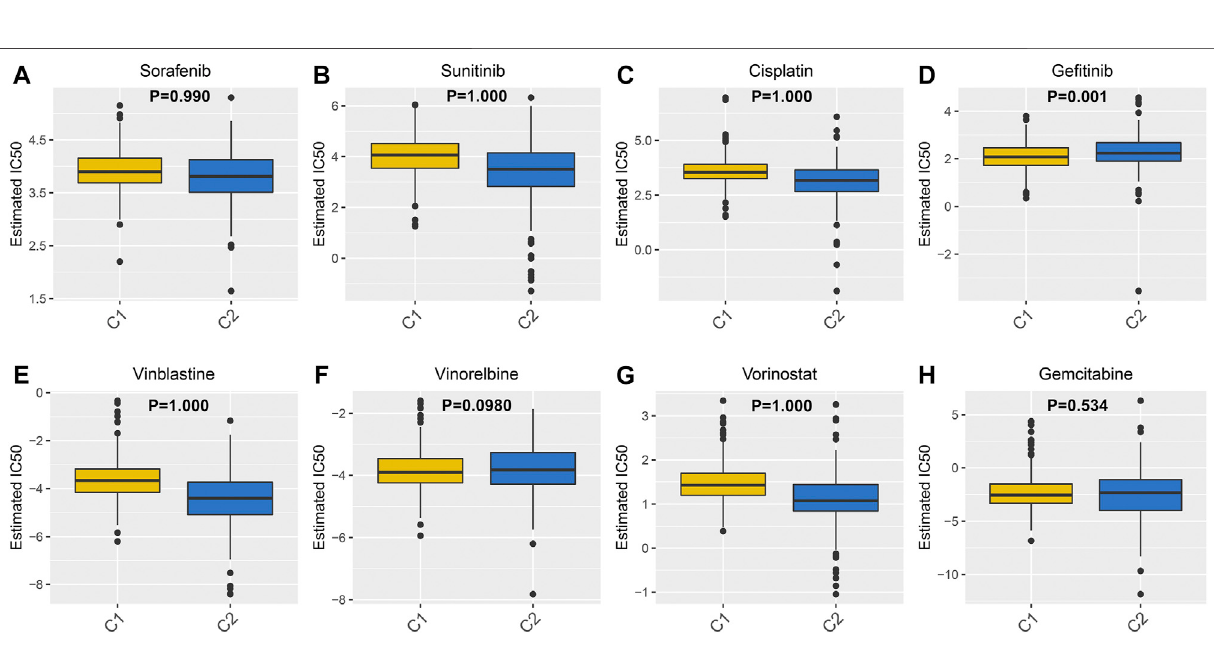
Frontiers in Molecular Biosciences |